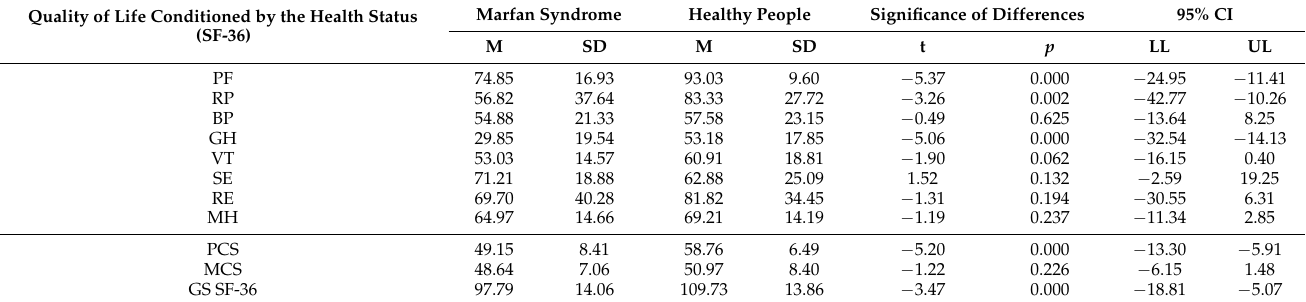
Table 4. The significance of the differences between a group with Marfan syndrome and a group of healthy people in the scope of the quality of life conditioned by the health